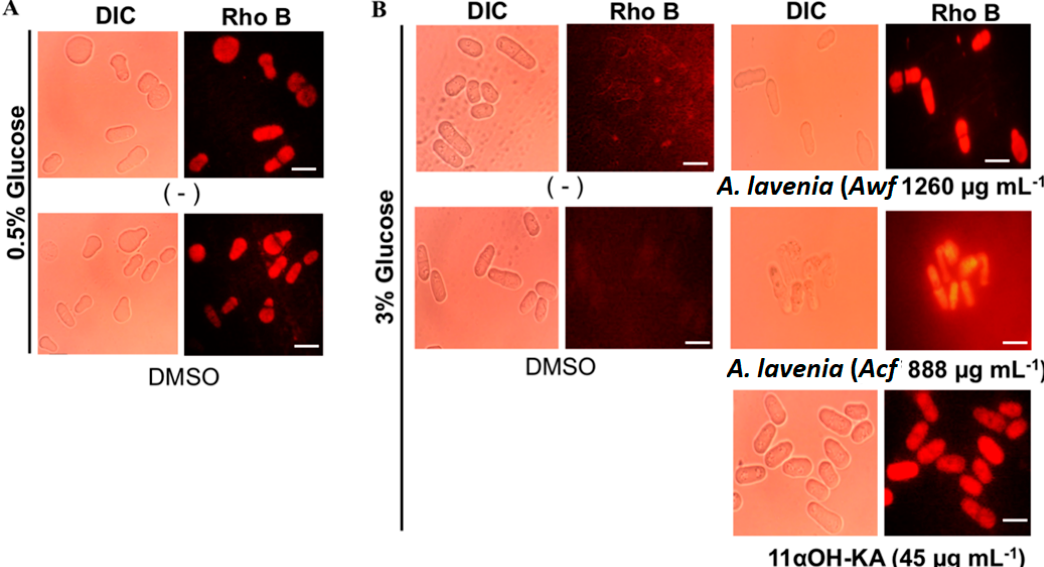
Figure 4. E ff ect of A. lavenia fractions and 11 α OH-KA on mitochondria activity. ( A ) S. pombe was incubated under CR conditions (0.5% glucose), and mitochondria with a high membrane potential were stained with rhodamine B (Rho B: red fluorescence signals). ( B ) The yeast cells were treated with fractions of A. lavenia water ( Awf ) or chloroform ( Acf ) or 11 α OH-KA and stained with Rho B. DIC: Di ff erential interference contrast. Bars represent 5 µ